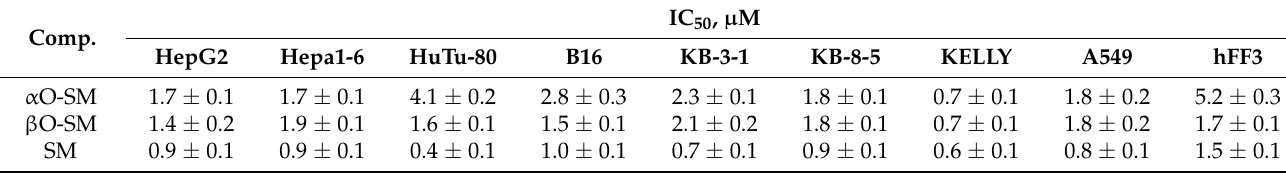
Table 1. Cytotoxicity of SM and its novel epoxide derivatives.